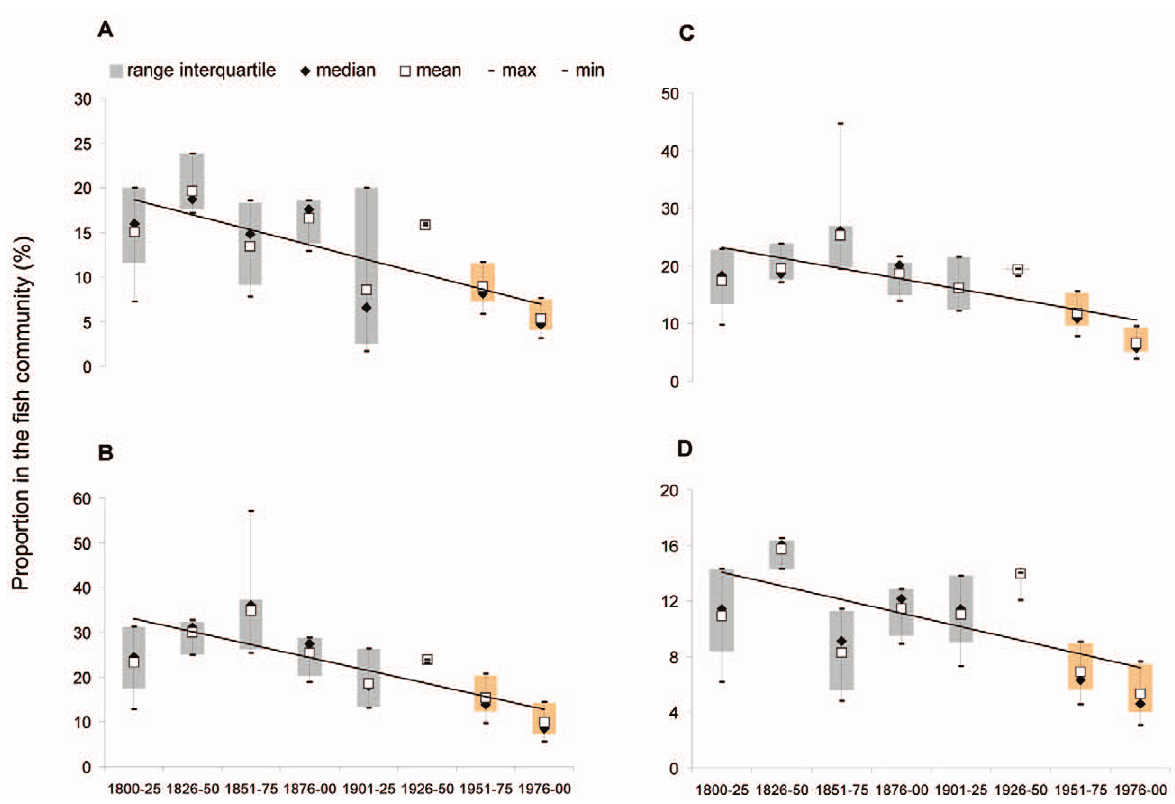
Figure 5. Temporal trends of fish community structure indicators in the period 1800–2000 (N=87 species/groups of species). Grey boxes indicate the naturalists’ observations of species’ perceived abundance, and orange boxes indicate the observed relative composition transformed into classes of perceived abundance. (a) Chondrichthyes; (b) large demersals; (c) species with a maximum body length between 120 and 250 cm; (d) species that reach sexual maturity between the 4 th and 6 th years of